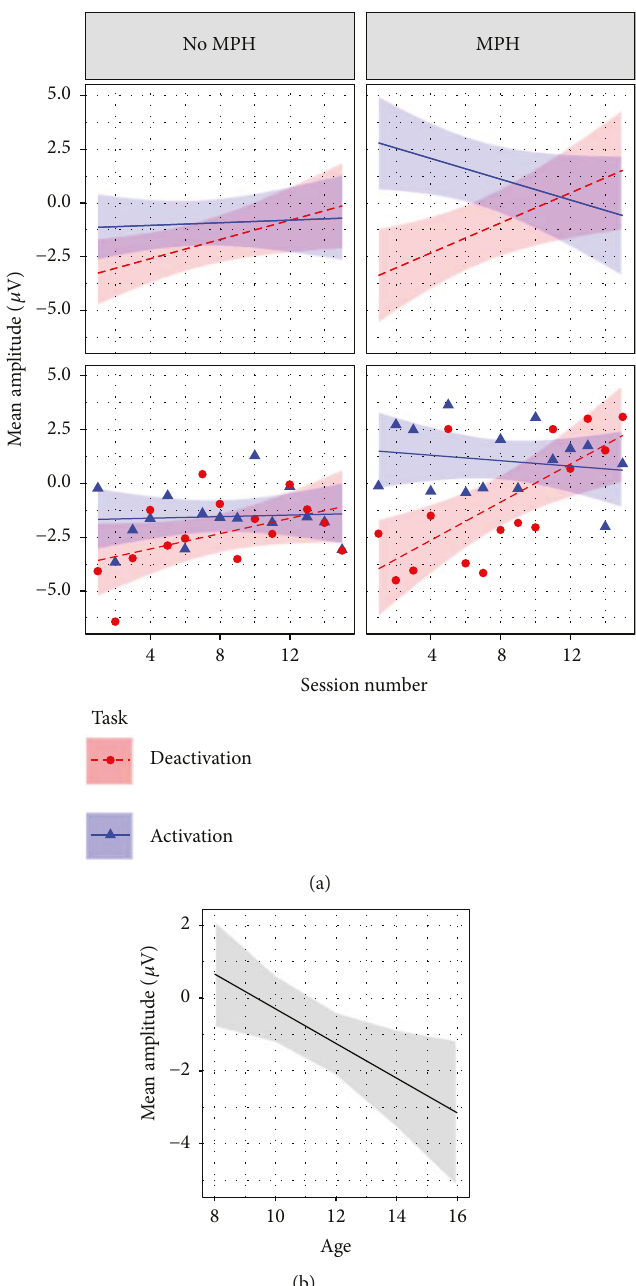
Figure 5: Visualization of e ff ects moderating cross-session NF learning in the transfer condition. (a) Interaction e ff ect between session, task, and MPH. Transfer condition: no continuous feedback stimulus visible. Task. Deactivation: generation of positive potential shifts. Activation: generation of negative potential shifts. MPH: being on constant methylphenidate medication. (b) Age e ff ect